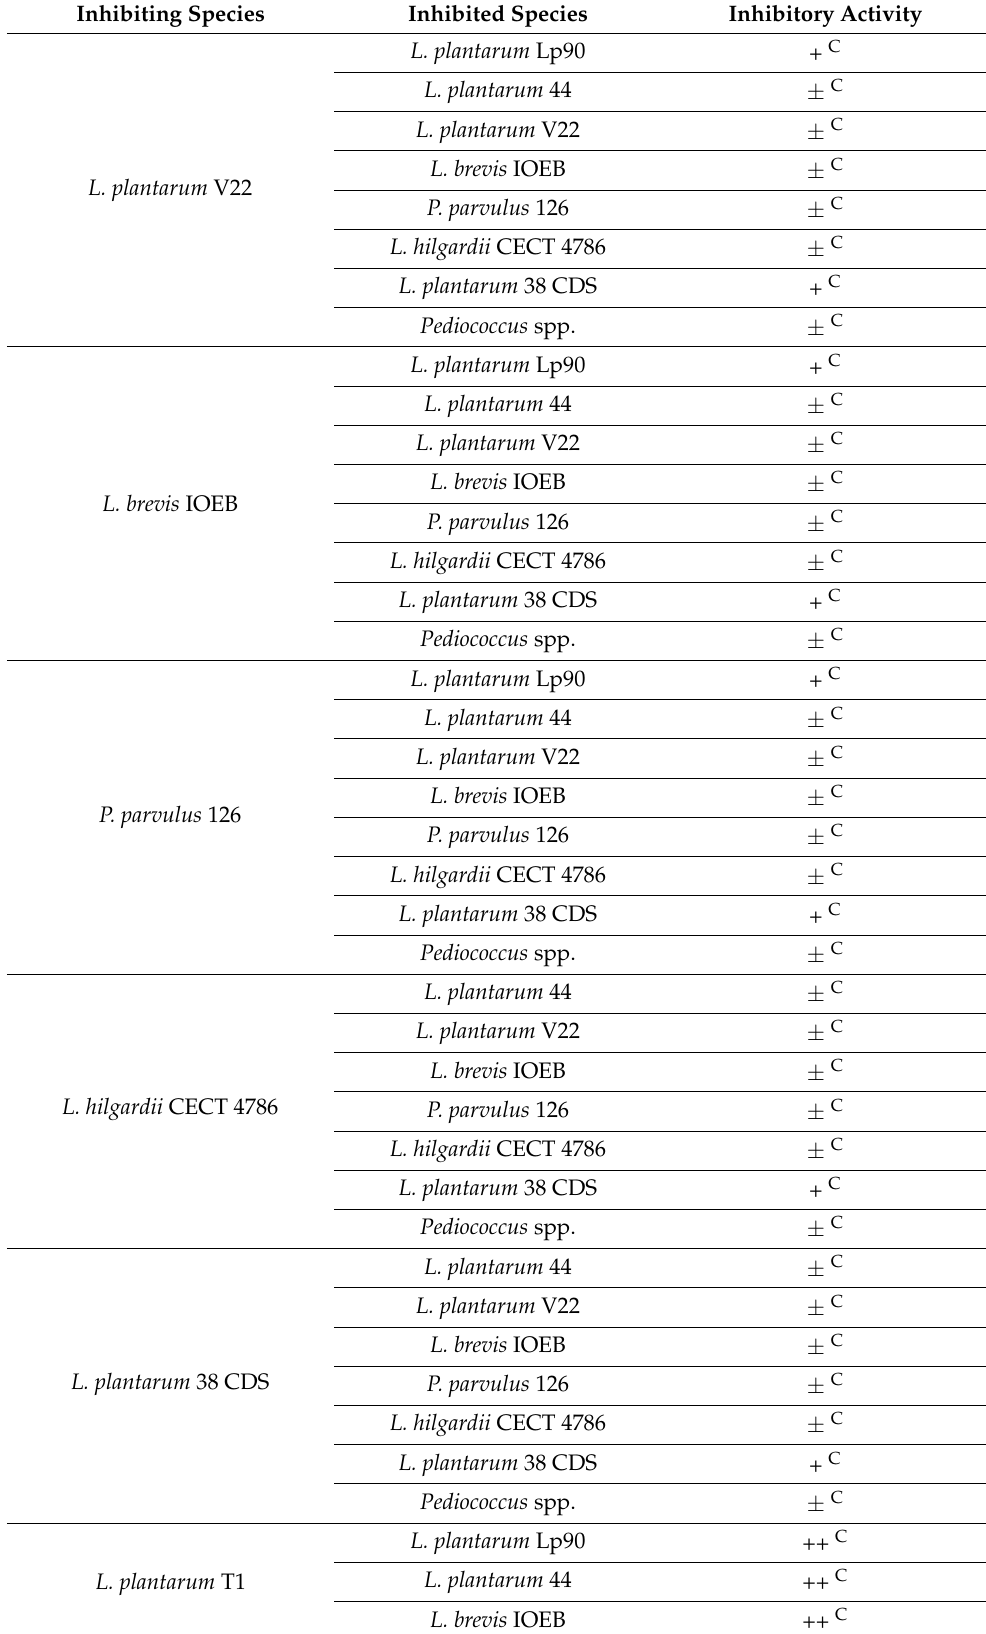
Table 4. Cont. Inhibiting Species Inhibited